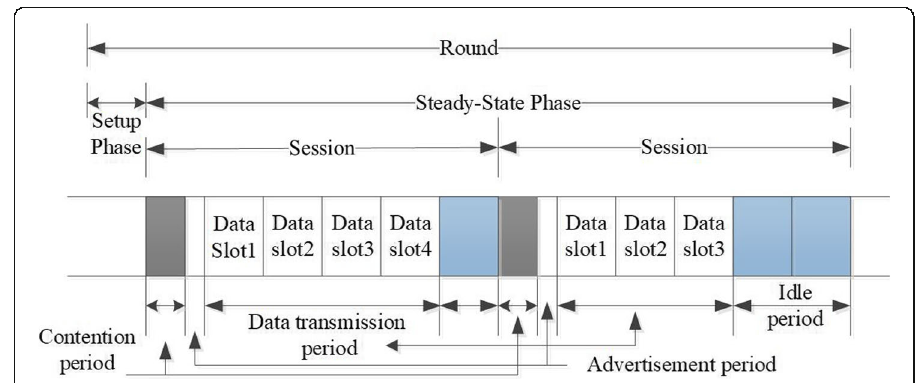
Fig. 2 Design of a single round